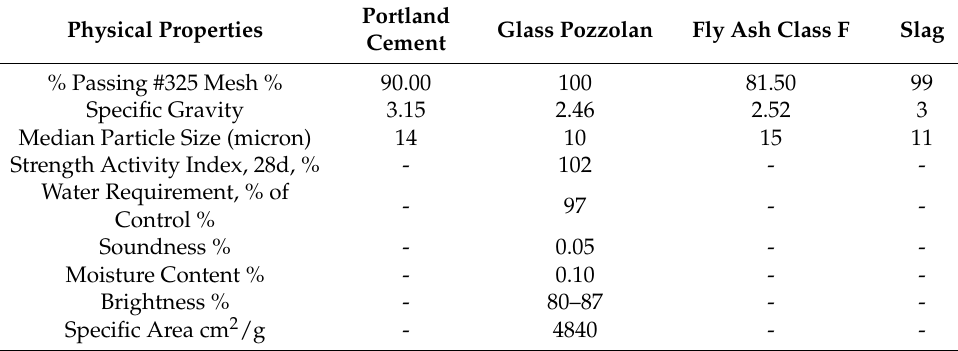
Table 2. Physical properties of raw